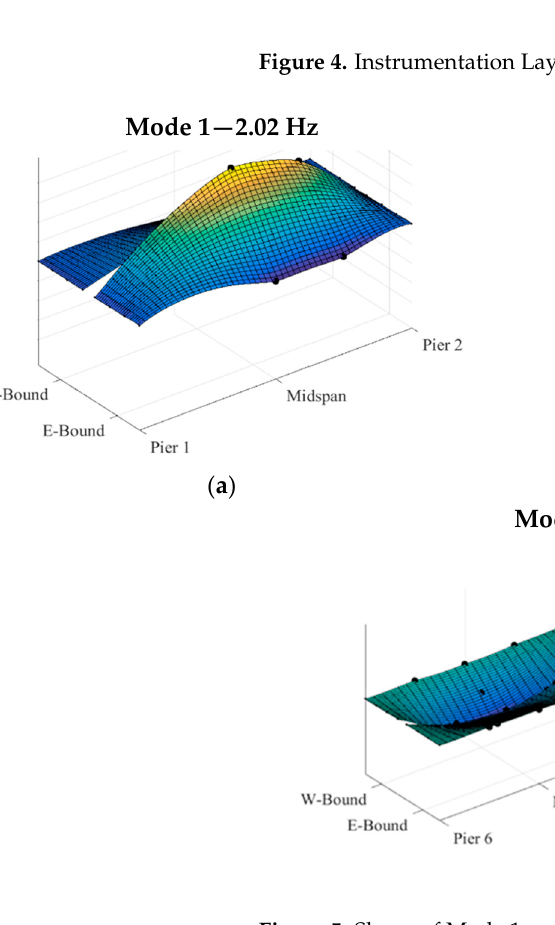
Figure 5. Shape of Mode 1 and the correspondent frequency from the dynamic testing (accelerometers): ( a ) Span 2; ( b ) Spans 3 and 4; ( c ) Spans 7 and 8 (not to scale).